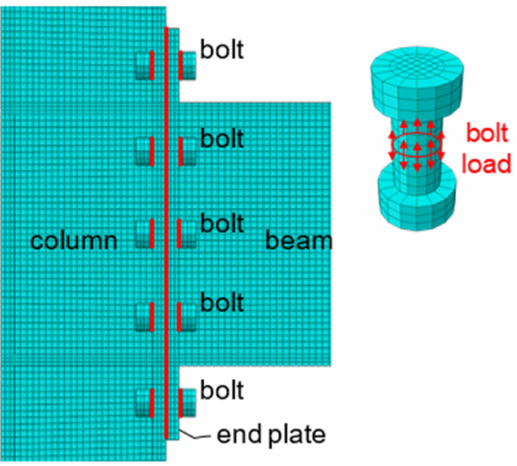
Figure 3. Contact pairs and bolt